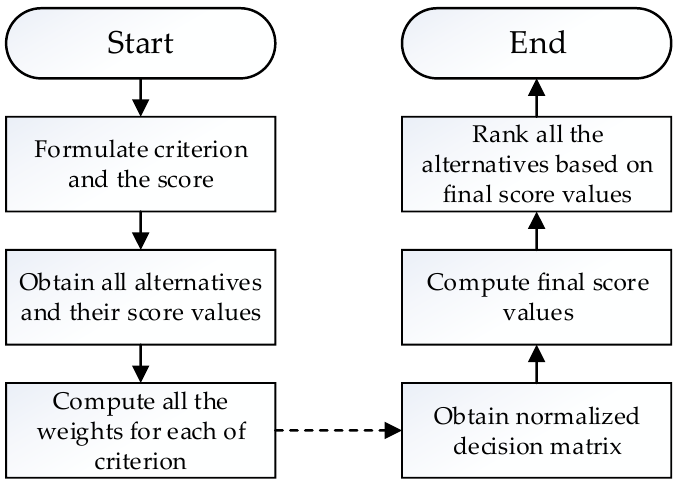
Figure 4. Simple additive weighting method.